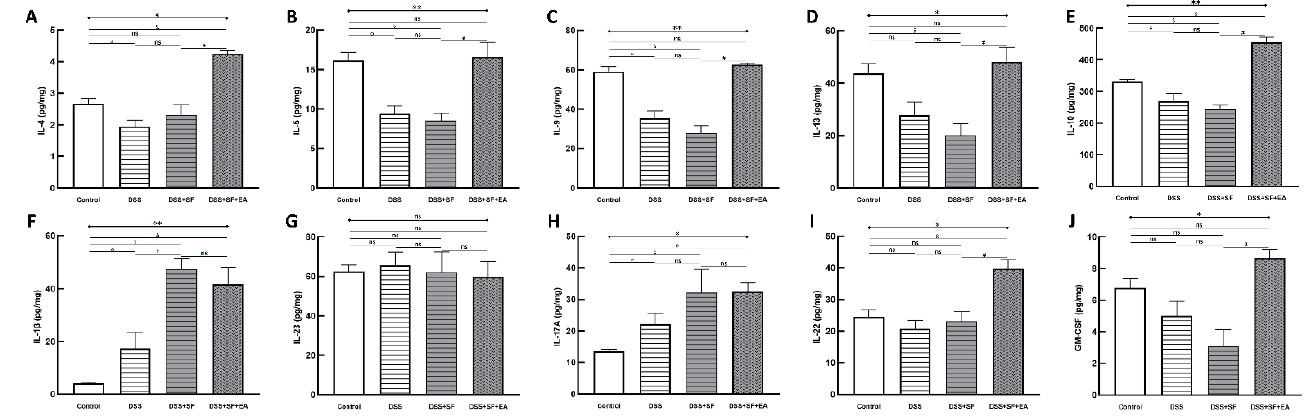
Figure 4. Electroacupuncture effect in colonic immunoassay in dextran sulfate sodium (DSS)-induced colitis in sleep fragmented C57BL/6 mice. ( A ) IL-4, ( B ) IL-5, ( C ) IL-9, ( D ) IL-13, ( E ) IL-10, ( F ) IL- 1 β , ( G ) IL-23, ( H ) IL-17A, ( I ) IL-22, and ( J ) GS-CSF concentration in colon tissue in four groups. Electroacupuncture performed significant increasement in Th2/ILC2 related cytokines ( A – E ), as well as ILC3-derived IL-22 and GM-CSF ( I , J ), but showed no obvious change over IL-1 β , IL-23, and IL-17A ( F – H ). * Stands for a result of four groups comparison (represented by bold line segments with endpoints). (cid:64) , (cid:63) , #, $ and & represent the results of control group versus DSS group, DSS group versus DSS + SF group, DSS + SF group versus DSS + SF + EA group, control group versus DSS + SF group, and control group versus DSS + SF + EA group, respectively (represented as a thin line without endpoints). *, (cid:64) , (cid:63) , #, $, &, p < 0.05; **, p < 0.01; ns, no significance. Data were presented as mean ± SEM of four mice in each group. DSS, dextran sodium sulfate; SF, sleep fragmentation; EA, electroacupuncture; IL, interleukin; GM-CSF, Granulocyte-macrophage colony-stimulating factor; ILC, innate lymphoid